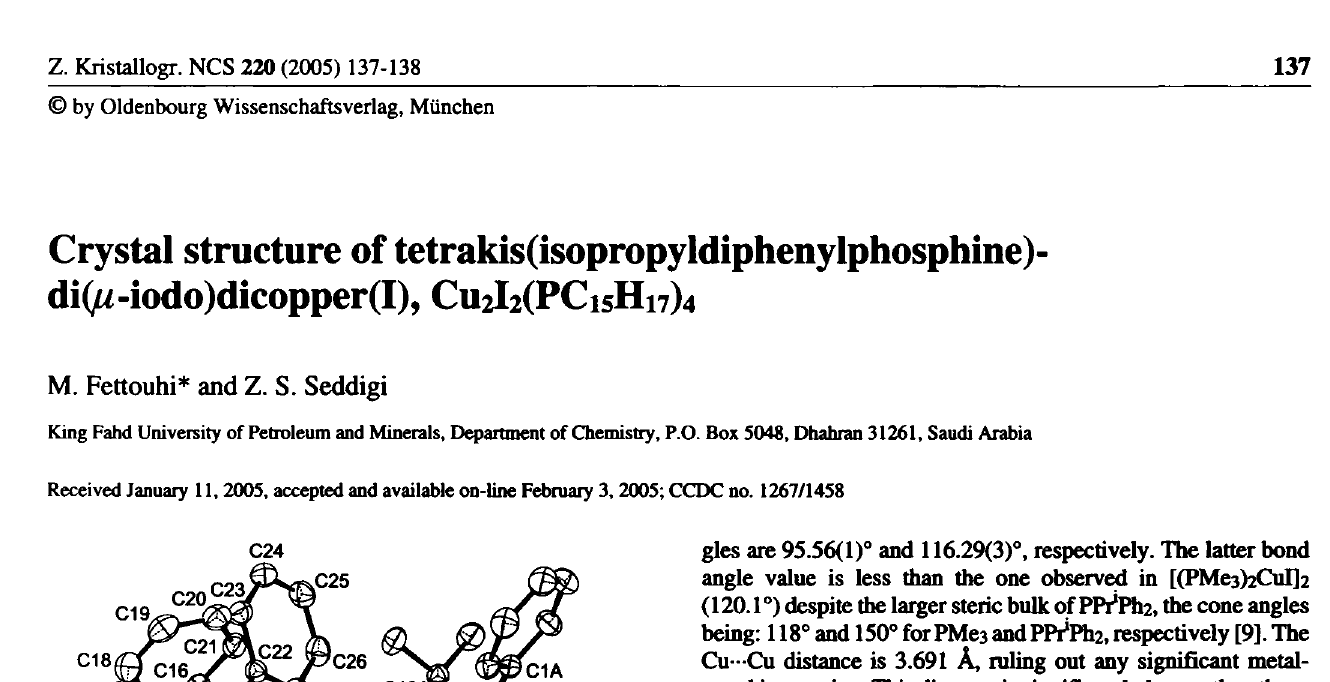
Table 1. Data collection and handling.